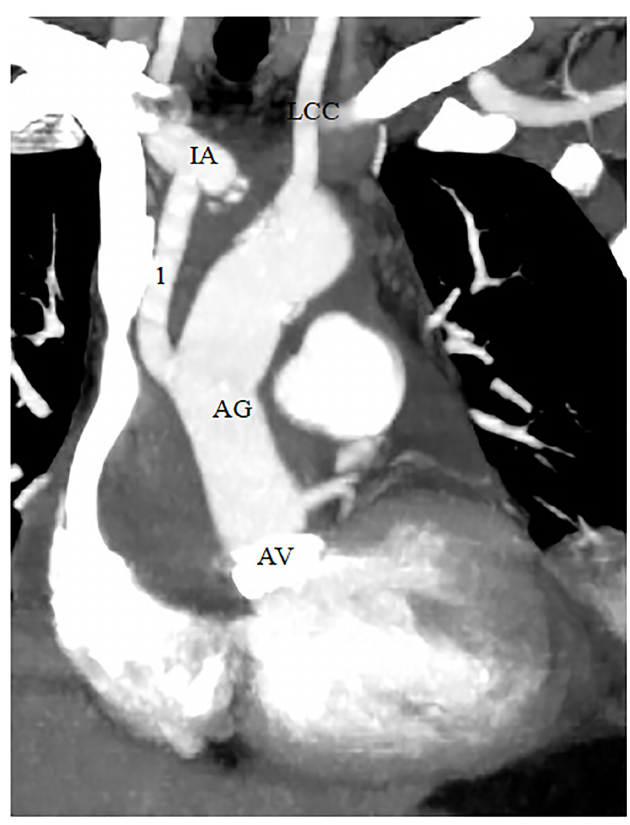
Fig. 3 - Using the innominate artery (IA) cannulation graft for proximal arch repair. Computed tomography angiography showing that the graft used for IA cannulation was anastomosed between the ascending aortic graft (AG) to IA in a patient who underwent Bentall and proximal arcus repair operation. AV=aortic valve; LCC=left common carotid artery; 1=graft to